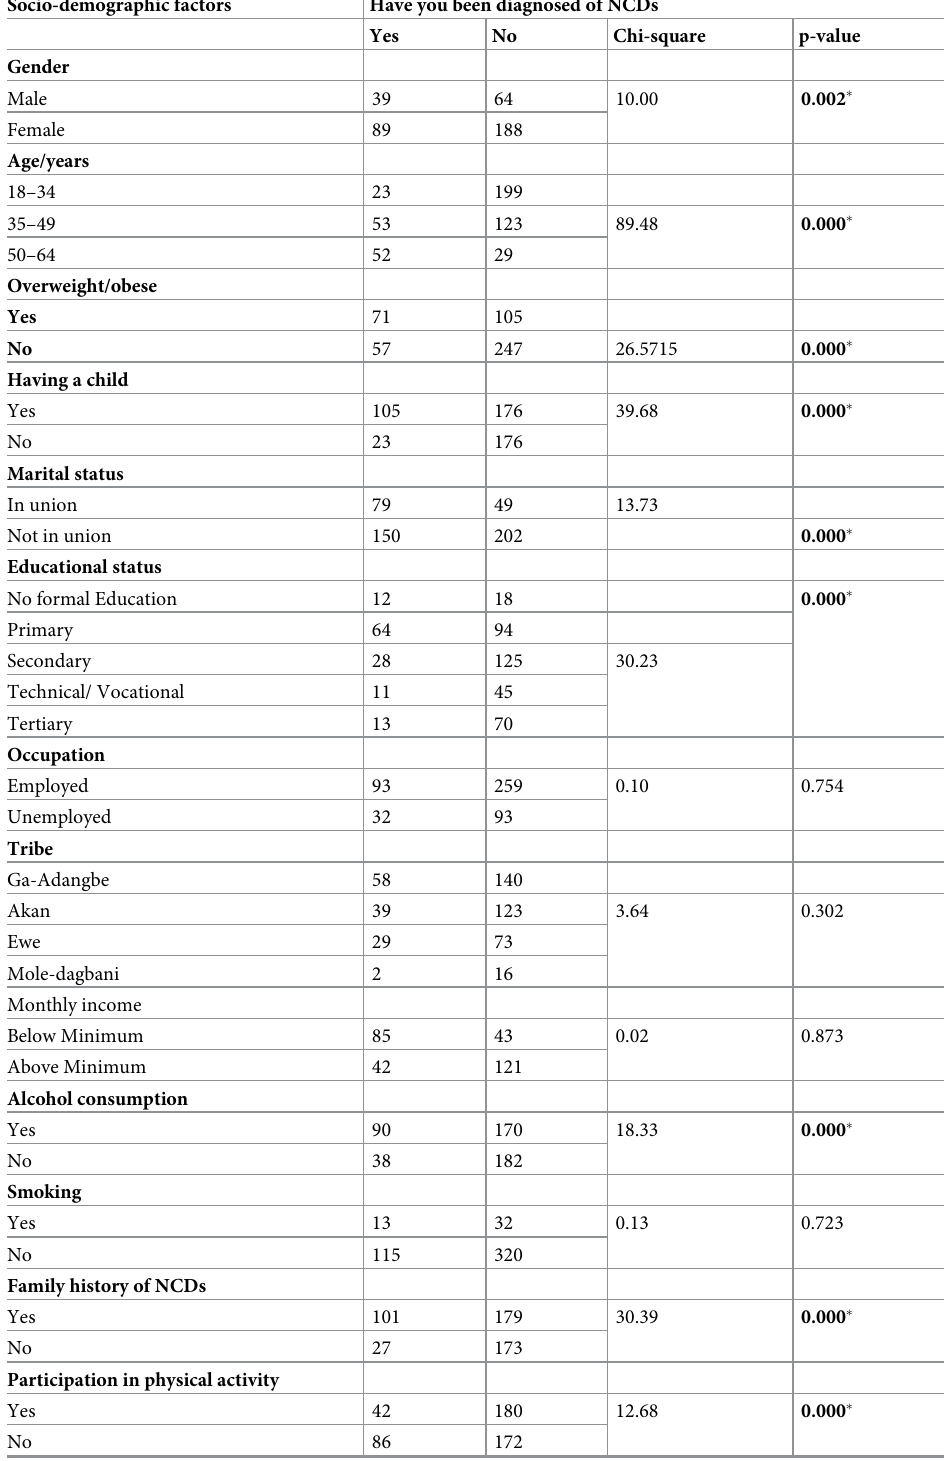
Table 4. Association of NCD risk factors by NCD